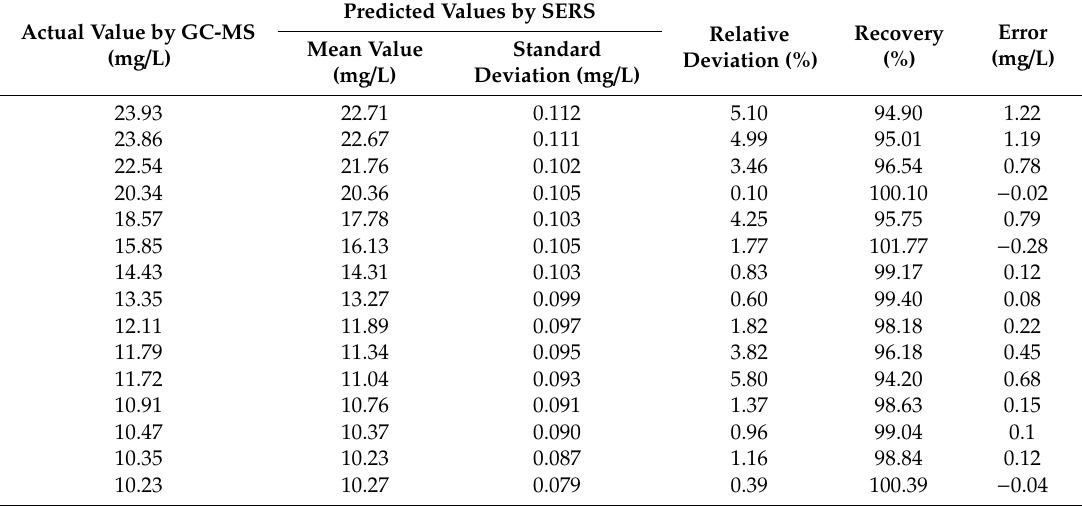
Table 3. Predicted results of contaminated wheat with pirimiphos-methyl using SERS, PLSR and PCA. Predicted Values by SERS Actual Value by GC-MS (mg/L)